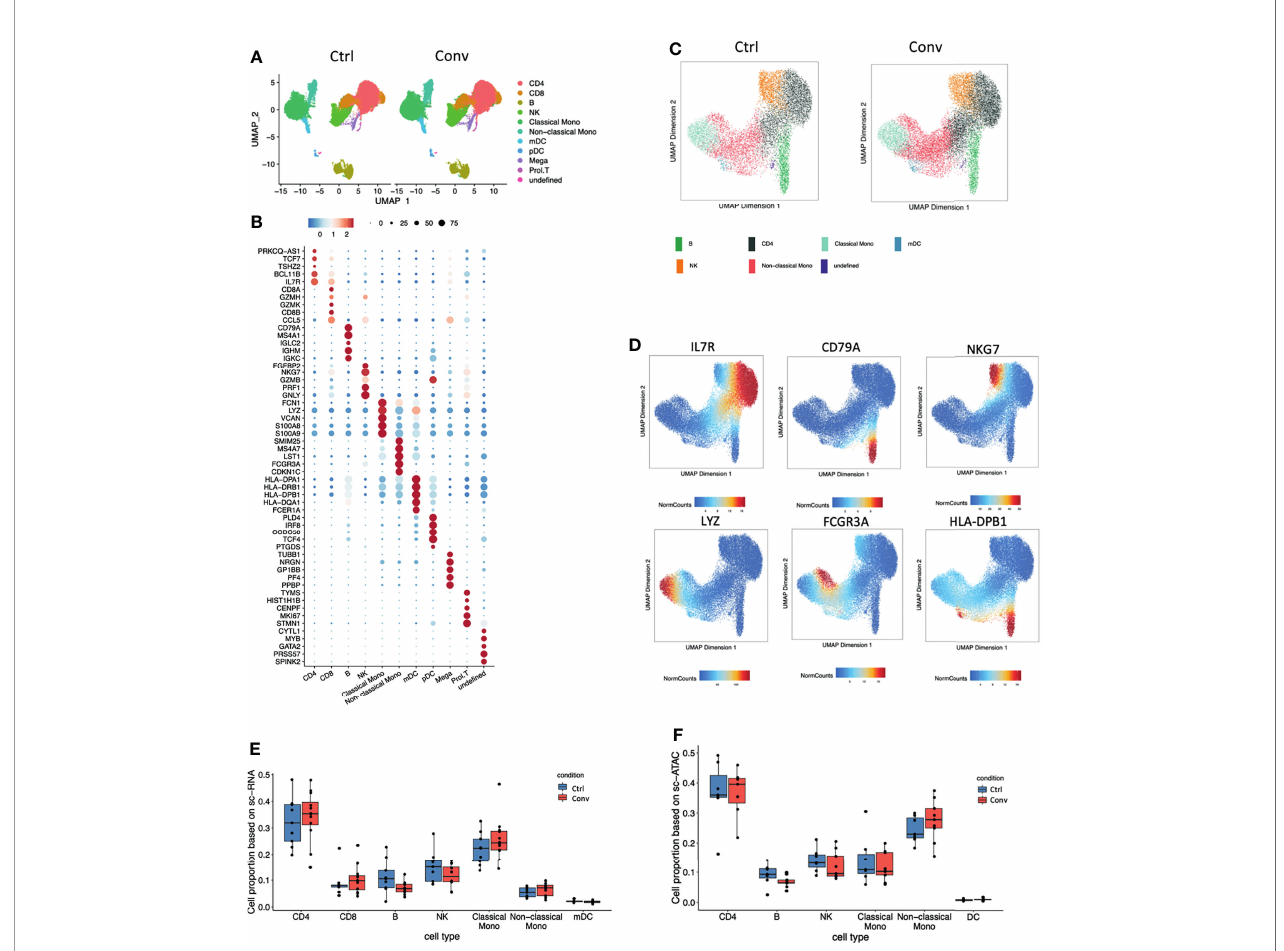
FIGURE 2 | Single-cell transcriptome and epigenome analysis de fi ned major immune cell subsets in convalescent COVID-19 individuals. (A) A total of 41486 and 25266 single-cell transcriptomes from COVID-19 convalescent and control samples were obtained respectively. Using the uniform manifold approximation and projection (UMAP) method, we captured 11 major cell types based on the canonical markers in the dot plots (B). (B) Dot plot showing the expression level of the marker genes in each cell type. Dot size re fl ects the proportion of cells expressing the indicated gene; the color encodes the average expression level (low=blue, high=red). (C) A total of 21102 and 17084 nuclei from 9 COVID-19 convalescent and 7 control samples were obtained respectively. Seven major cell types were captured based on the canonical markers shown in the feature plot(D). (D) The UMAP showing the labelled gene score for each cell. Blue represents the minimum gene score while red represents the maximum gene score for the given gene. The minimum and maximum scores are shown in the bottom of each panel. The gene of interest are shown in the upper of each panel. Cell proportions from (E) single-cell RNA sequencing and (F) single-cell ATAC dataset between convalescent COVID-19 and controls in the seven main cell types, CD4+ T cells, CD8+ T cells, B cells, NK cells, classical monocytes, non-classical monocytes, and